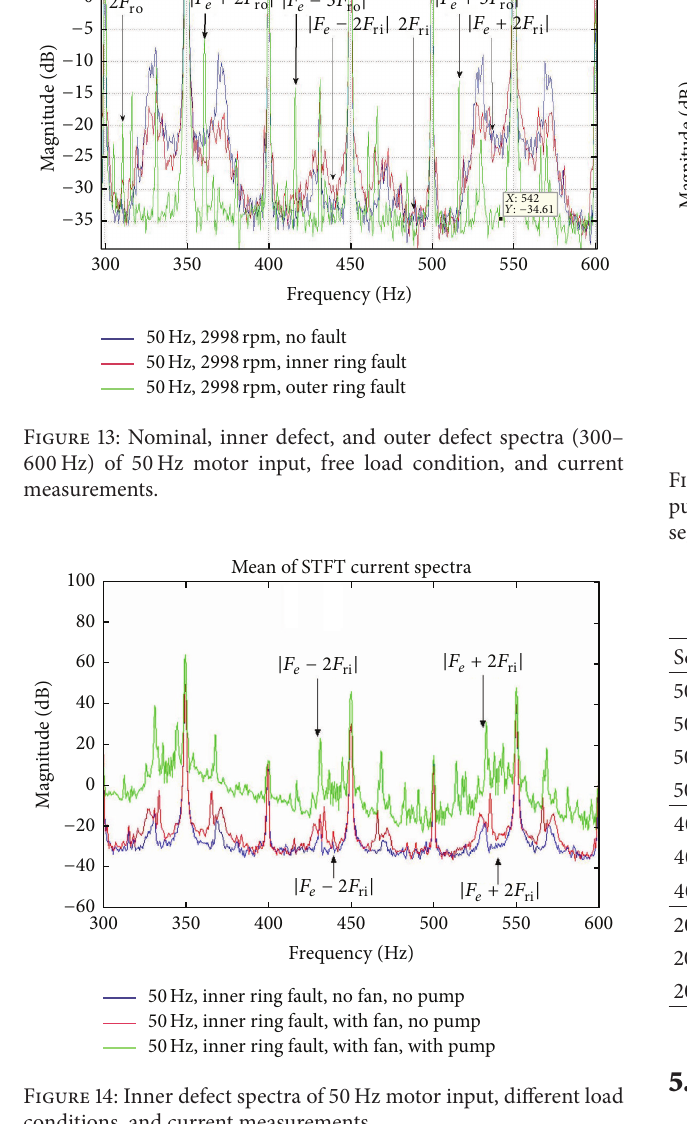
Figure 14: Inner defect spectra of 50 Hz motor input, different load conditions, and current measurements.